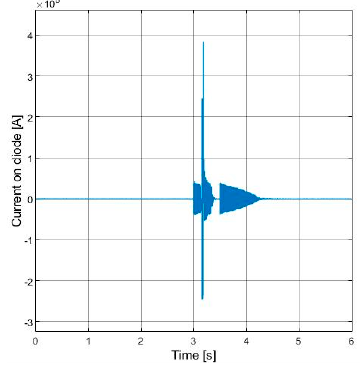
Figure 12. Series diode loop current waveform.